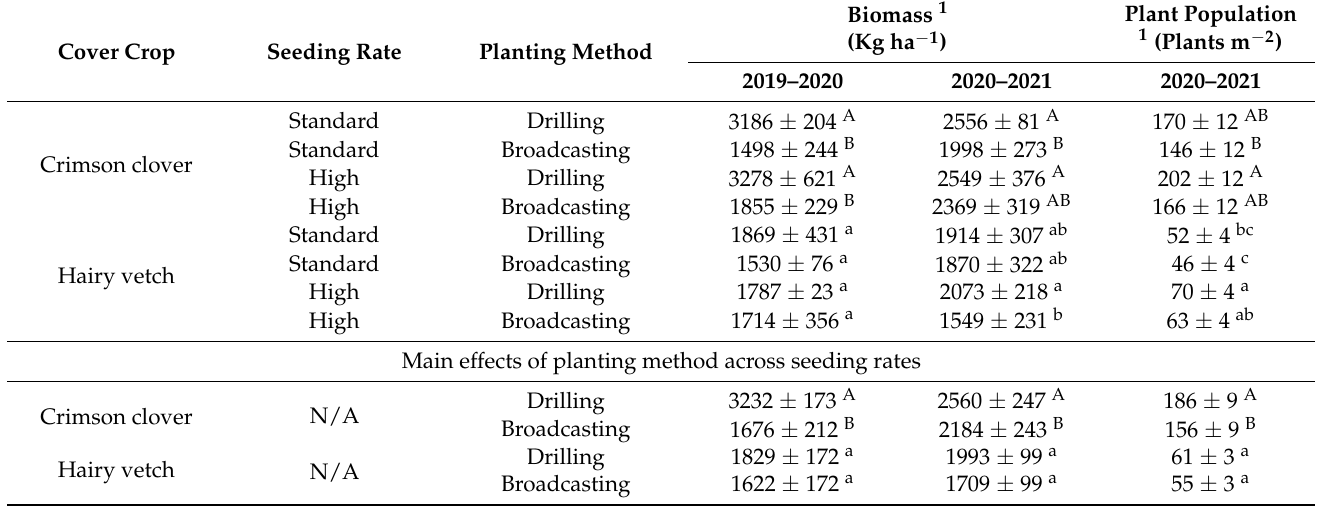
Table 2. Biomass production and plant population of crimson clover and hairy vetch under two different planting methods (broadcasting and drilling) and seeding rates [standard [12], 22.4 kg ha − 1 and 50% higher, 33.6 kg ha − 1 ]. Plant population was measured at 61 days after